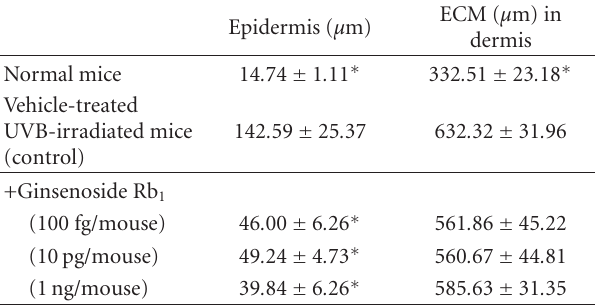
Table 4: E ff ects of ginsenoside Rb 1 on the thickness of the epidermis and extracellular matrix (ECM) of the dermis at week 12 in UVB-irradiated hairless mice [31].